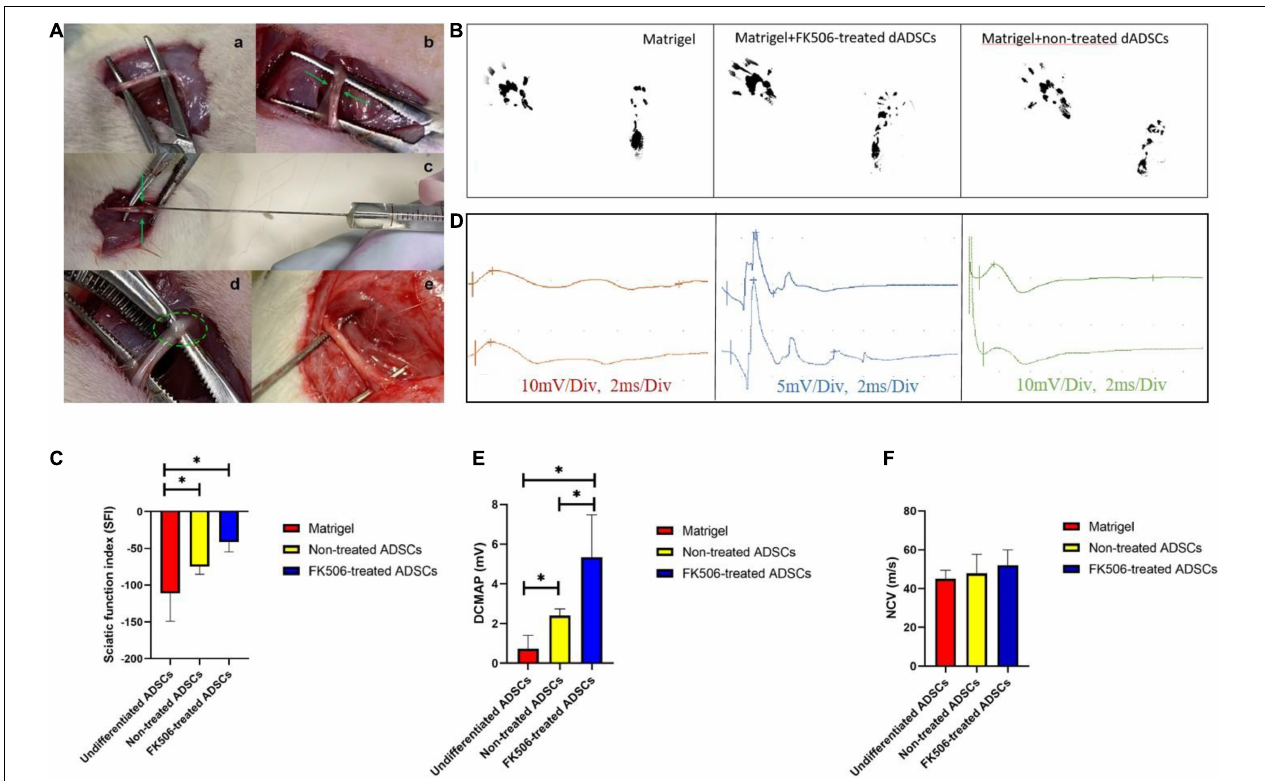
FIGURE 5 | (A) Sciatic nerve injury model and Matrigel administration. The crushed site and injection site were indicated by green arrow and green circle respectively. (a) Sciatic nerve exposure. (b) Crush injury. (c) Matrigel injection through microliter syringe. (d) Matrigel in the epineurium. (e) Sciatic nerve was exposed again at 3 weeks post-injection. (B) Representative footprints of rats treated with Matrigel, FK506 treated ADSCs and non-treated ADSCs. (C) Gait analysis after cell transplantation. The improvement of the SFI in FK506-treated ADSC group was significantly superior ( p < 0.05) to those in the non-treated groups. Both cell transplantation group showed significant improvement compared with the Matrigel control group. Data are expressed as means ± SD. ∗ P < 0.05, compared with non-treated ADSC transplantation group. (D) Representative oscillograms of each group at 3 weeks post-surgery. (E,F) The DCMAP and NCV evaluation in different groups. ∗ P < 0.05 DCMAP data from FK506-treated and non-treated dADSC group was significantly higher compared with Matrigel